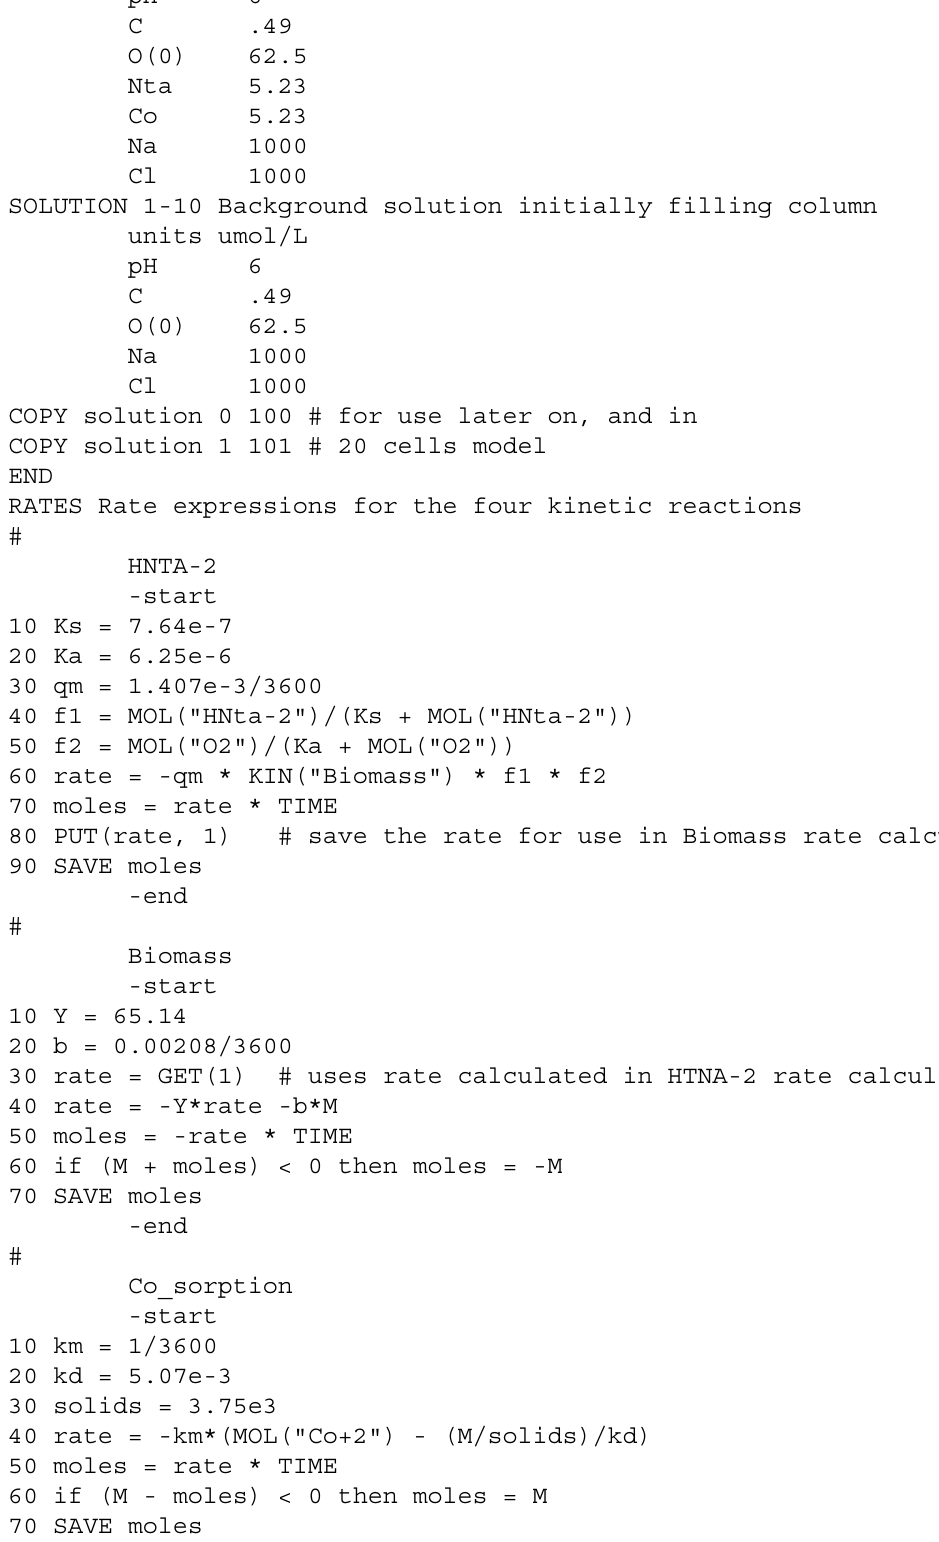
Table 44. Input file for example